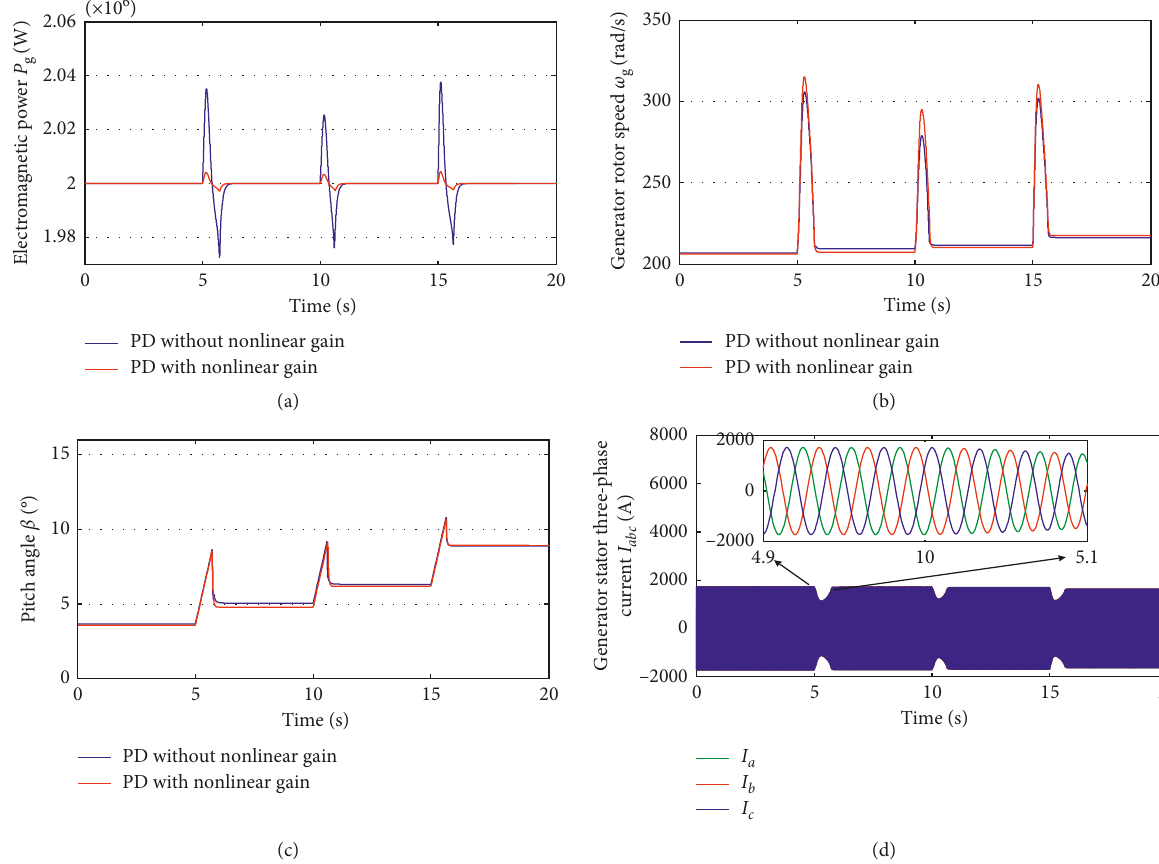
Figure 18: Responses under PD control. (a) Electromagnetic power curve. (b) Generator rotor speed curve. (c) Pitch angle curve. (d) Generator stator three-phase current under PI nonlinear